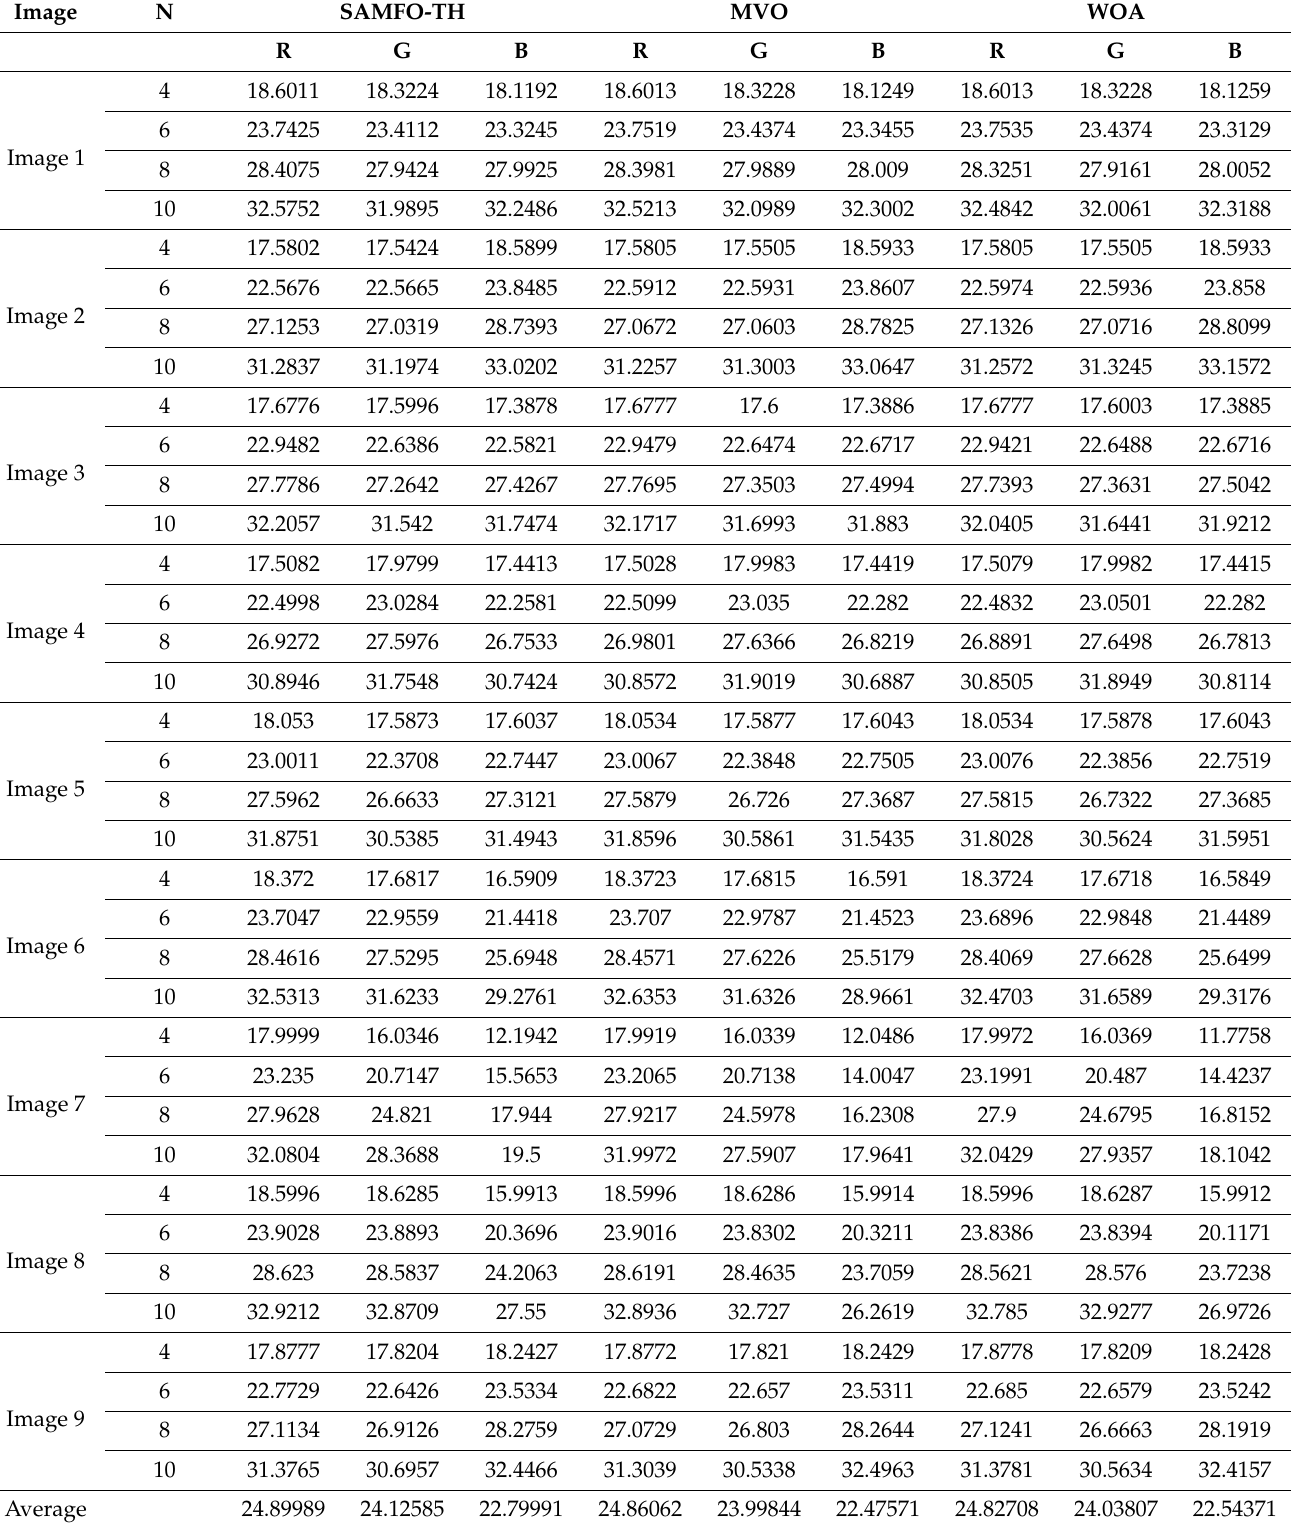
Table 16. Comparison of MEAN computed by SAMFO-TH, MVO, and WOA using Kapur’s method with N = 4, 6, 8, and 10 for red, green, and blue